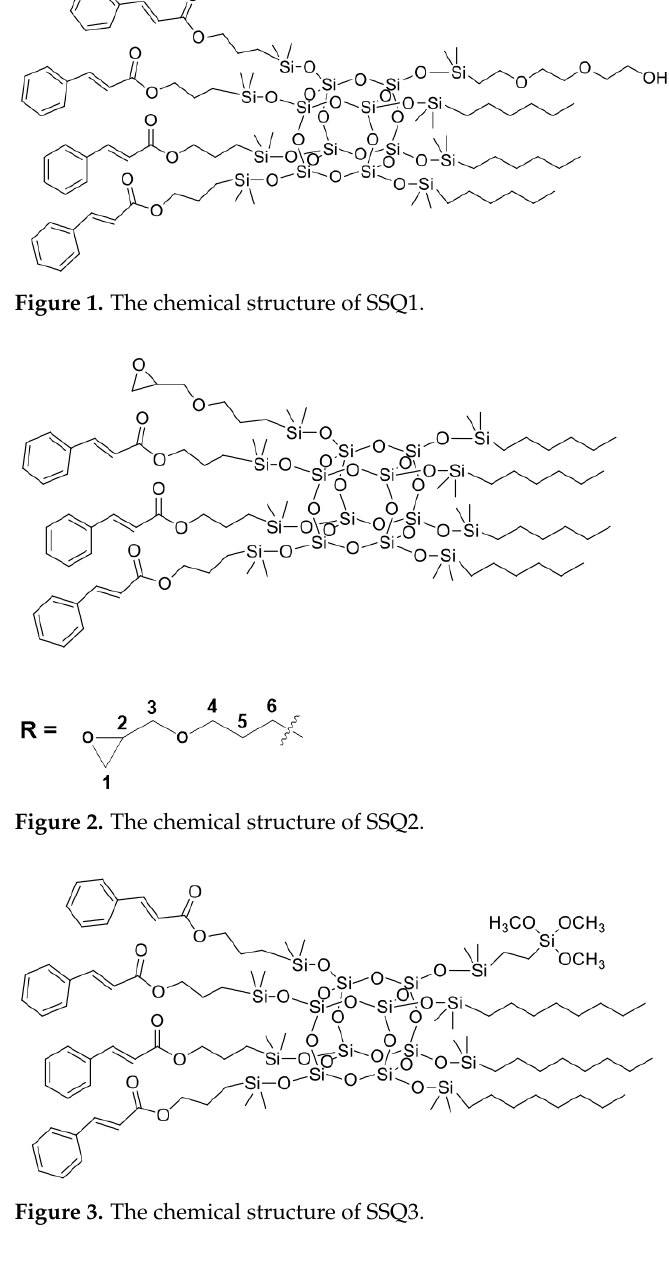
Figure 1. The chemical structure of SSQ1.